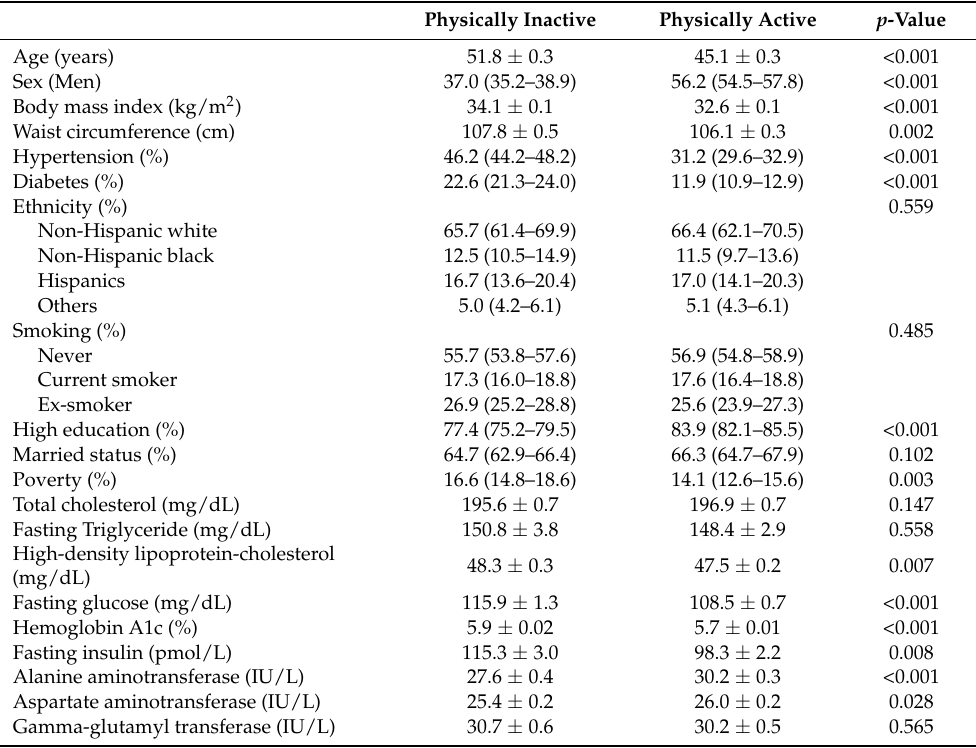
Table 1. Characteristics of Study Participants based on Total Physical Activity Status ( n =